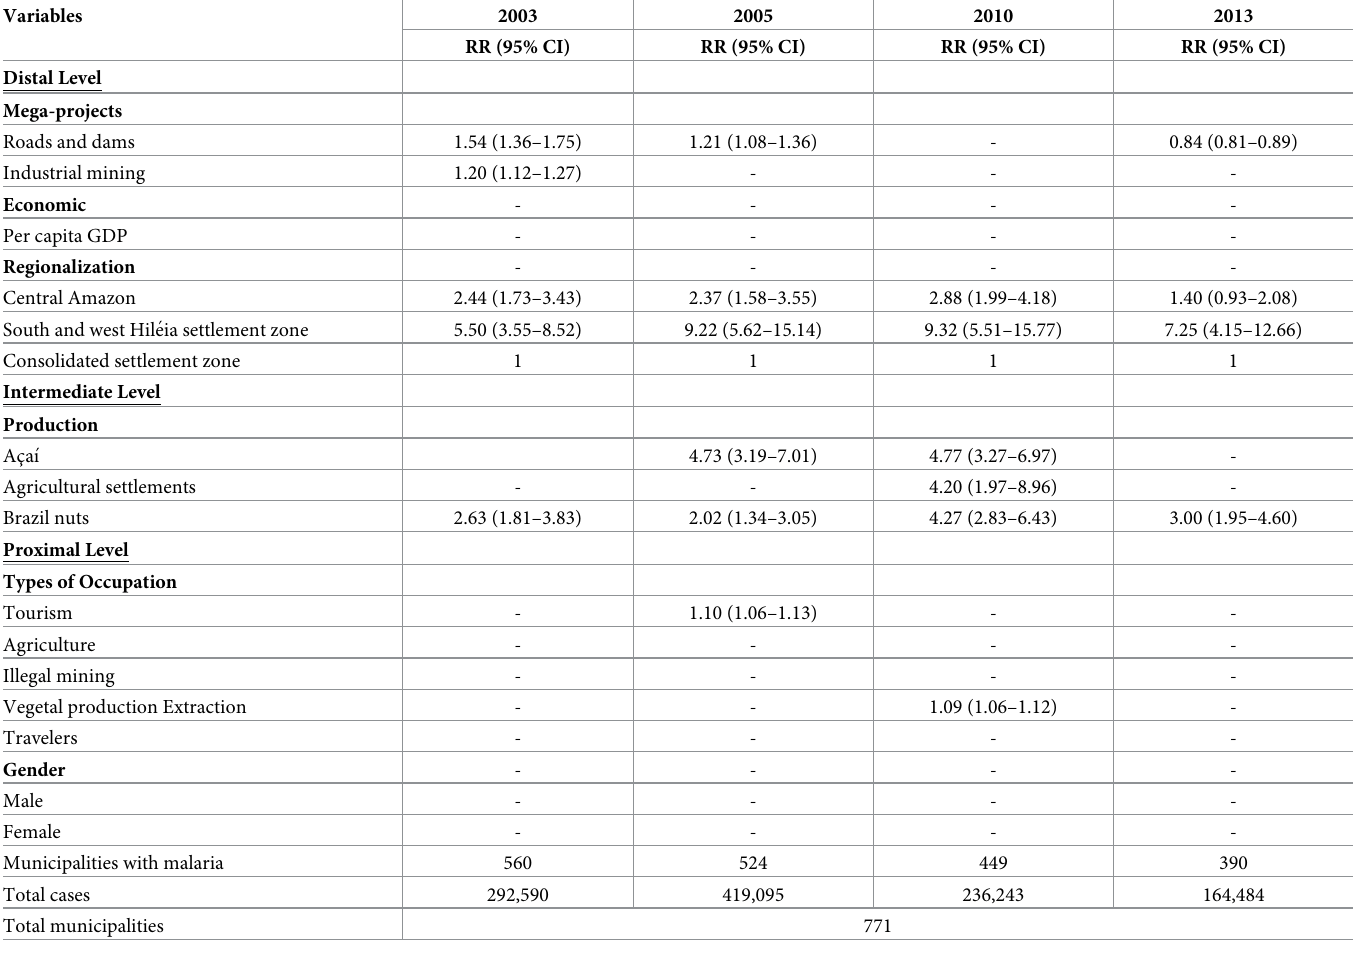
Table 5. Risk factors of malaria associated with occupation for all Plasmodium species by